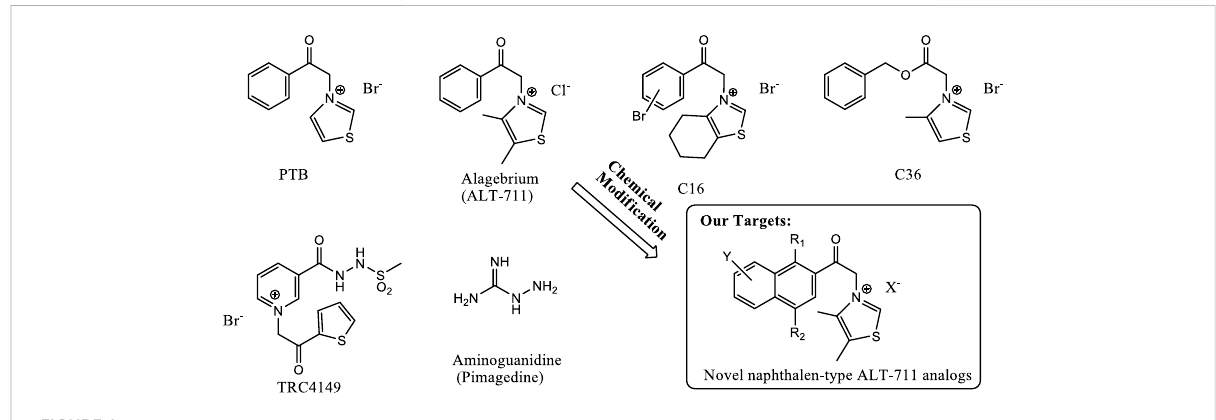
FIGURE 1 Structures of previously known AGEs breakers and our target molecules. The structure of PTB, alagebrium, C16, C36, TRC4149, aminoguanidine, ALT-711, and ALT-711 analog are presented here for further understanding of KHAG series compounds